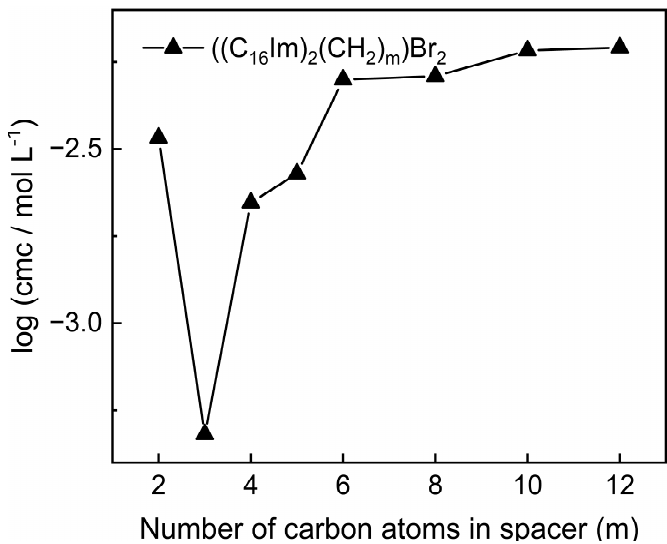
Figure 7. cmc as a function of spacer length from m = 2–12 in ((C ₁₆ Im) ₂ (CH ₂ ) m )Br ₂ series [157].